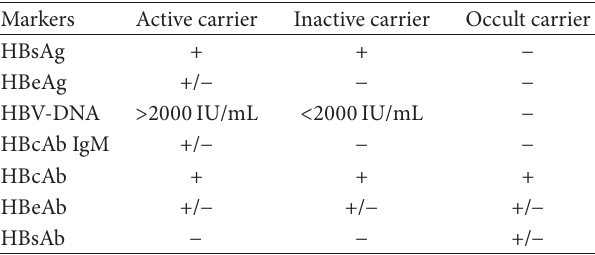
Table 1: Relevant virologic categories of hepatitis B